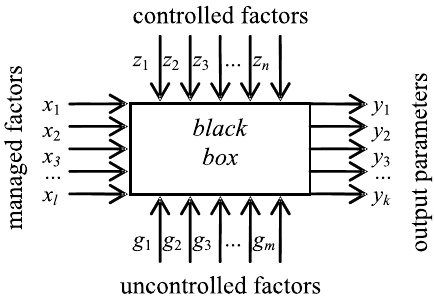
fig. 1. The scheme of the influence of different factors on the managed